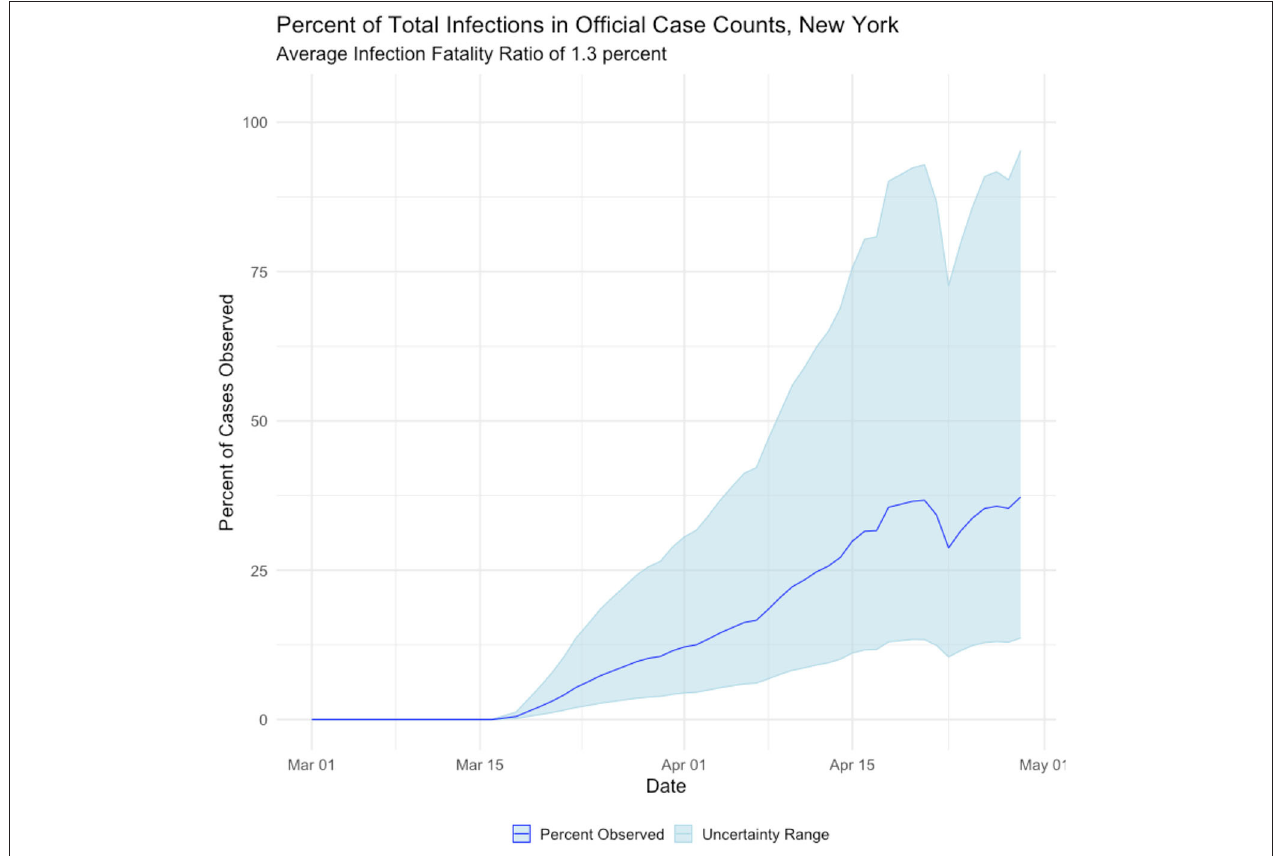
FIGURE 5 | Observed Percentage of Estimates Reflected in Official Case Counts, New York